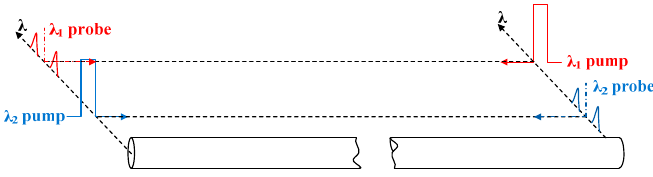
Figure 1. Principle of BD-BOTDA: two pump-probe pairs including pulsed pumps and CW probes at two wavelengths are injected into both ends of the FUT in opposite directions.